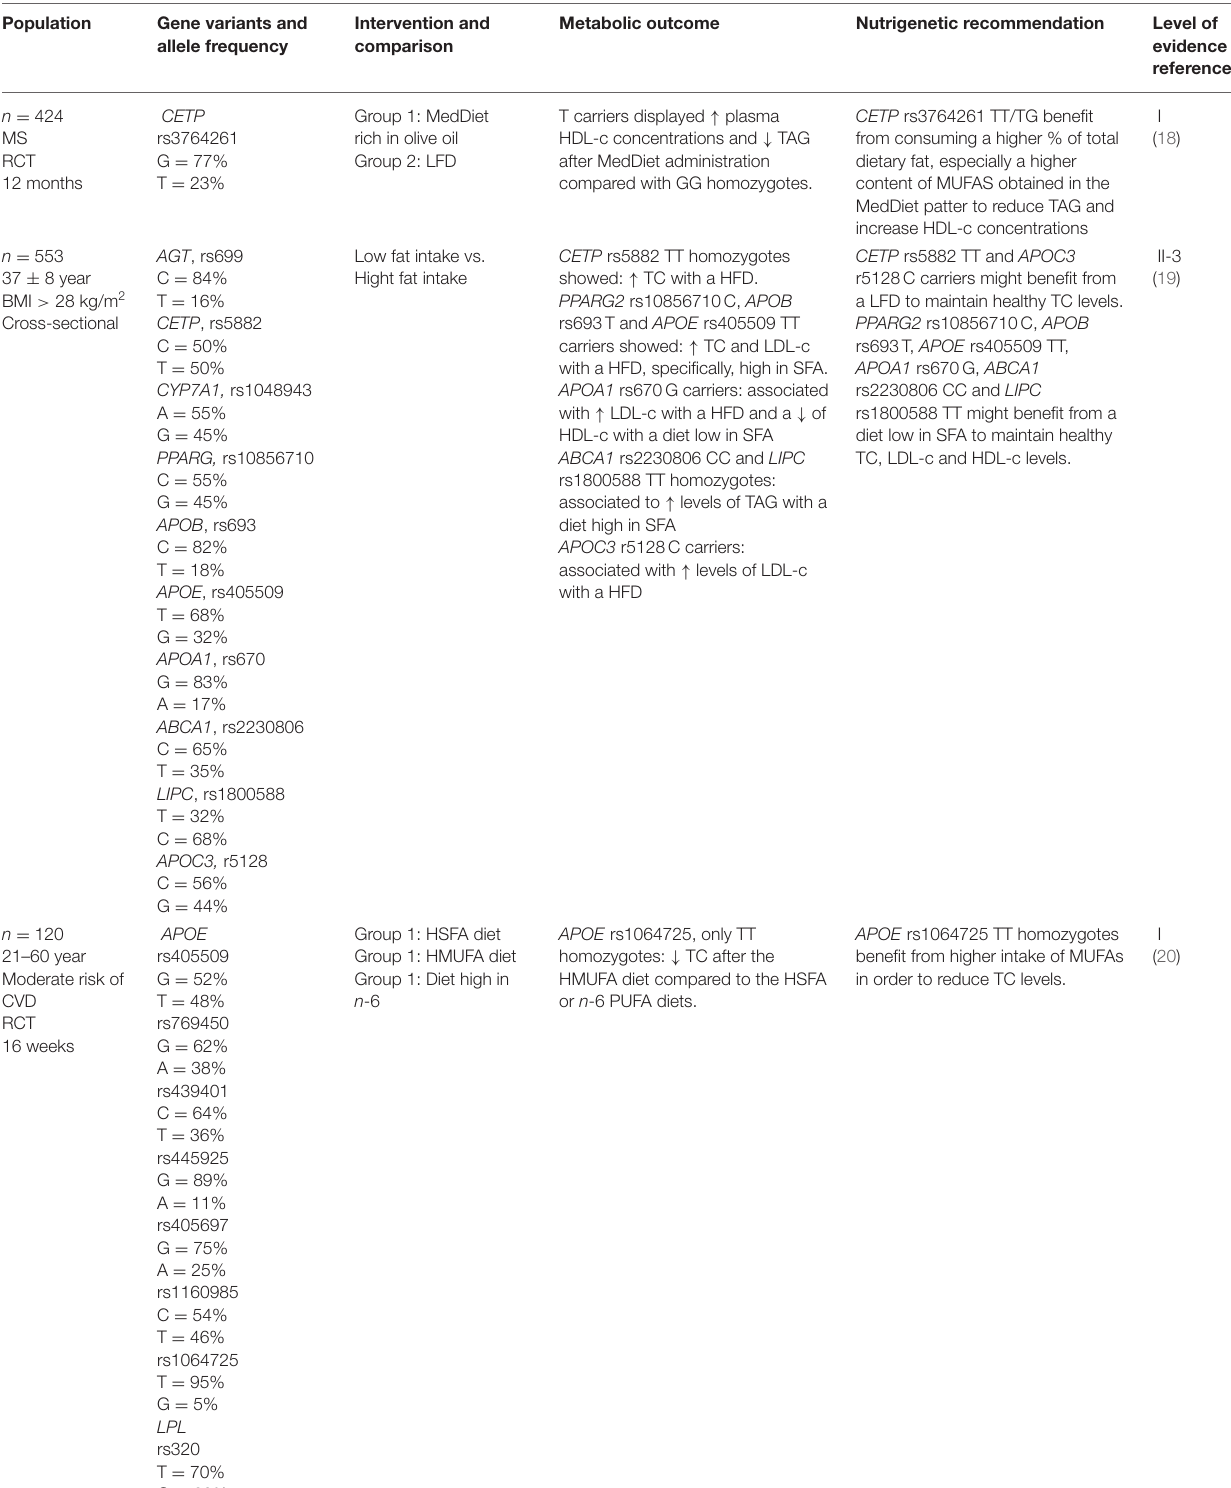
TABLE 1 | Gene diet interaction with dietary fats. Population Gene variants and Intervention and Metabolic outcome Nutrigenetic recommendation Level of allele frequency comparison